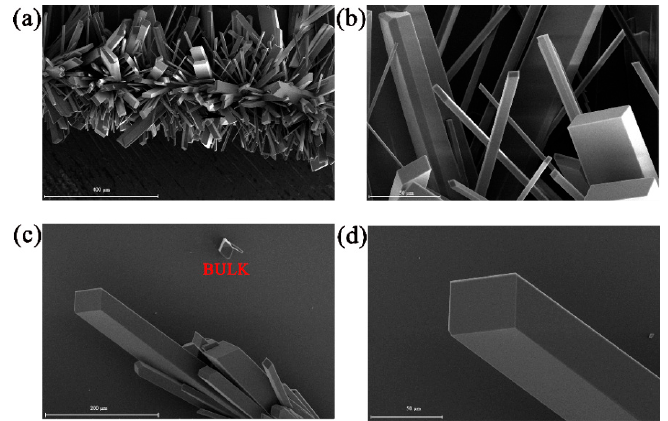
Figure 2. The SEM micrographs of the prepared Mnq 2 crystals. Rod-shaped microstructures with ( a ) 400 μ m and ( b ) 50 μ m scale. Rod-shaped and nubby microstructures with ( c ) 200 μ m and ( d ) 50 μ m scale.